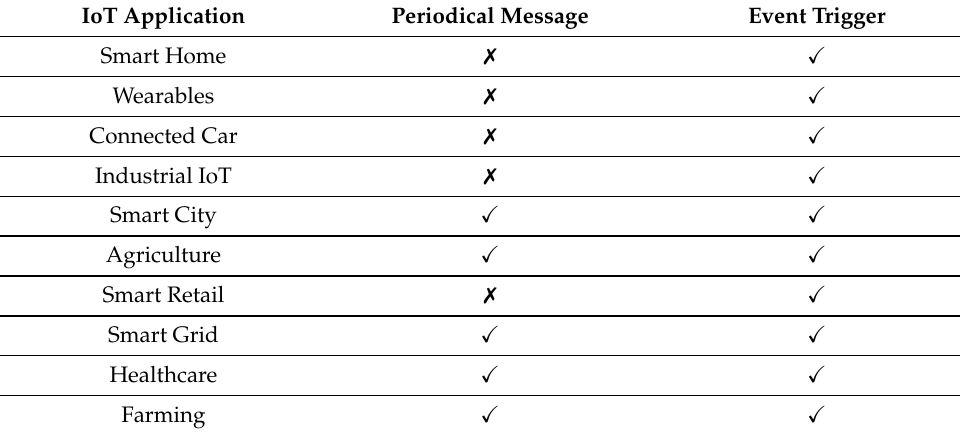
Table 3. Traffic nature of IoT